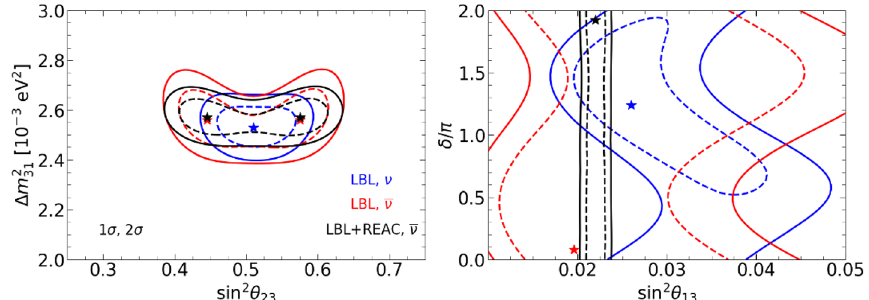
Figure 4 . 1 (cid:27) (dashed) and 2 (cid:27) (solid) allowed two-dimensional projections from the combined analysis of neutrino data (blue), antineutrino data from long-baseline accelerators alone (red) and combining with reactors (black). The stars correspond to the best (cid:12)t values obtained in each